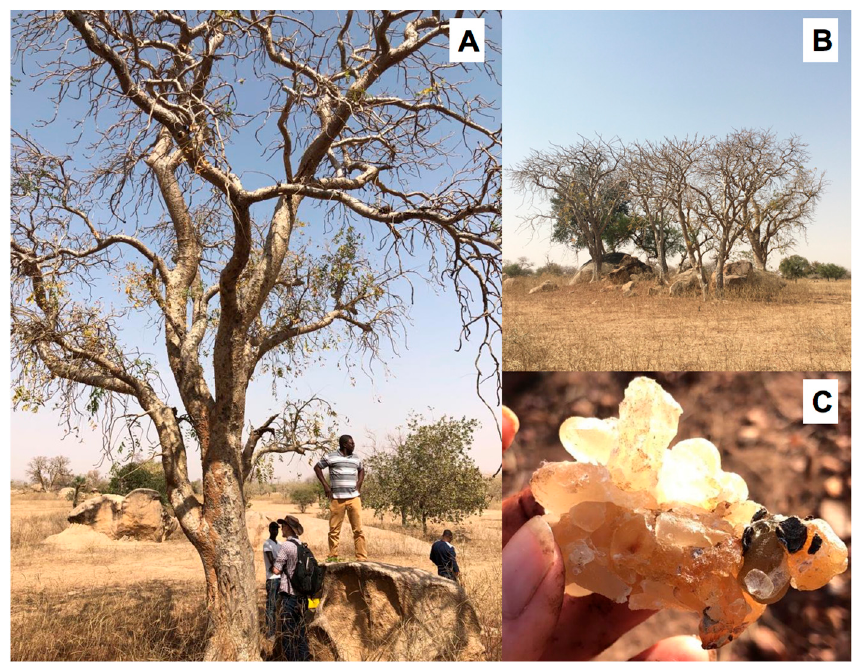
Figure 1. Boswellia dalzielii tree in situ ( A ); Grove of B. dalzielii trees ( B ); Oleogum resin from self-exuded by a B. dalzielii tree ( C ).